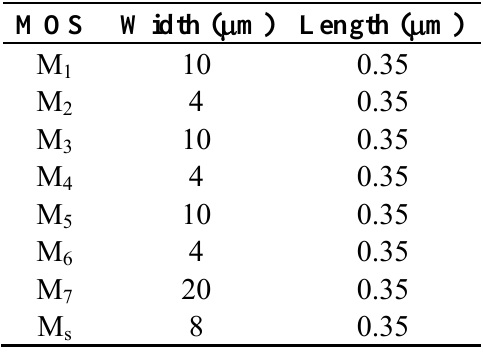
Table 1. Channel width and length of all MOS in the wireless pressure sensor.